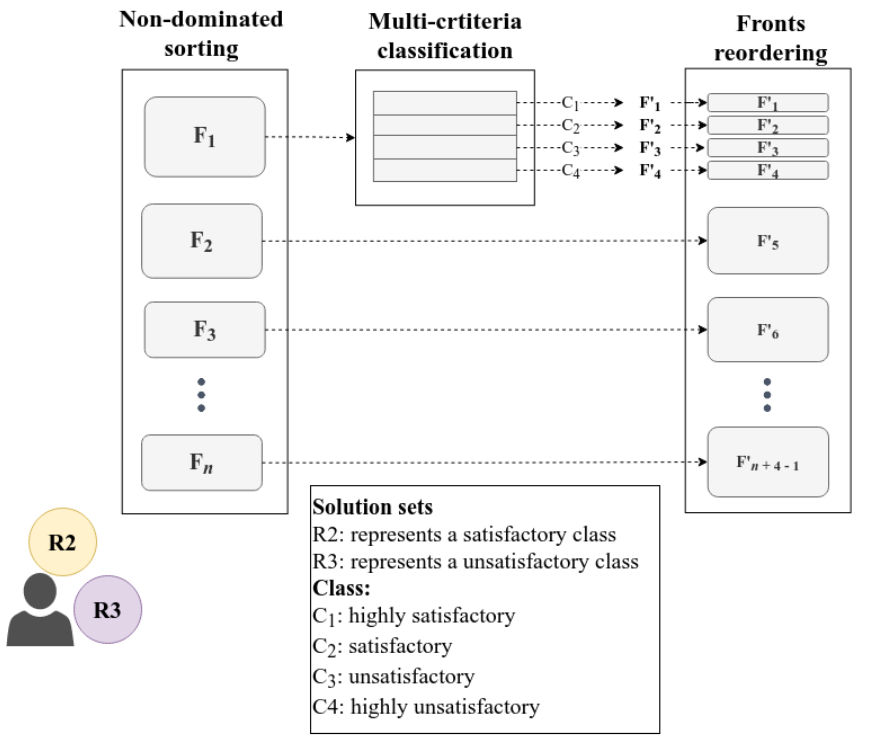
Figure 1. The proposed methodology for classifying the F 1 , grouping, and fronts reordering. After F (cid:48) the new population is built until the size is N . The last front is called the l -th 1 front. Therefore, the front l + 1 are rejected; in most situations, l is partially accepted. Only the solutions that maximize the diversity of l -th are selected in such a case (steps